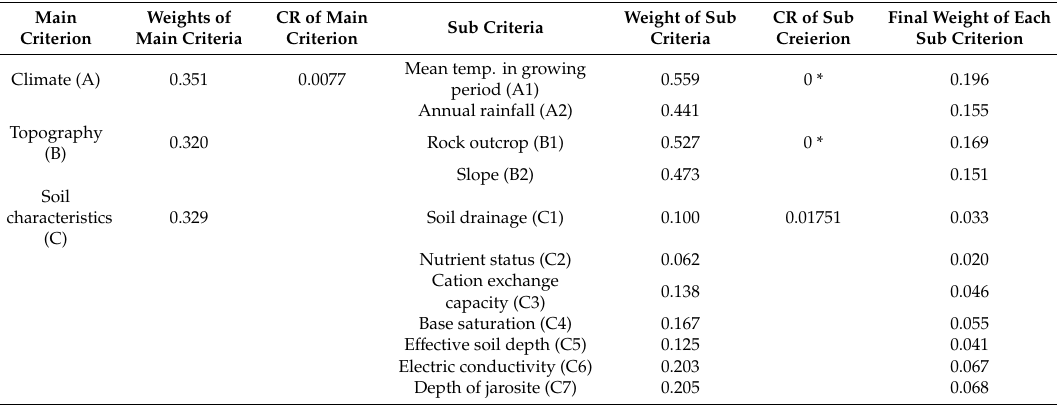
Table 8. Weights of all criteria using triangular fuzzy